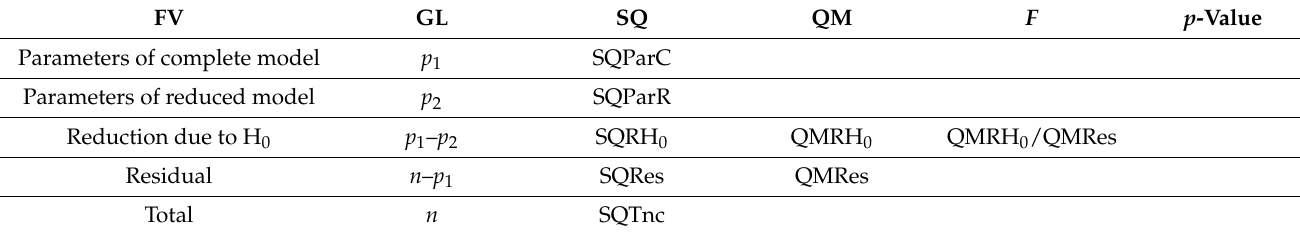
Table 3. Analysis of variance for the identity test models aiming to compare [49] model adjusted to different datasets (treatments) *. FV GL